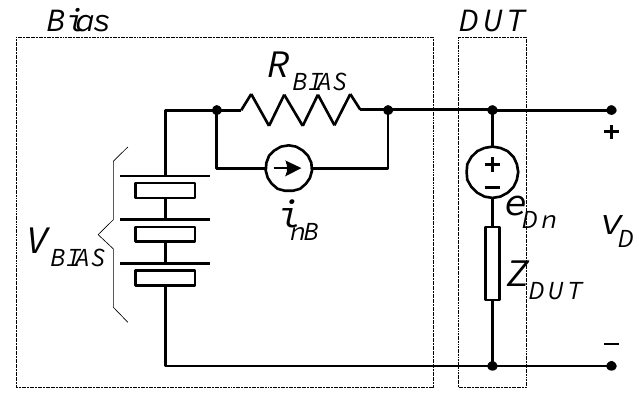
Figure 10. Block diagram for the calculation of the contribution to the voltage noise across the DUT as due to the bias network.